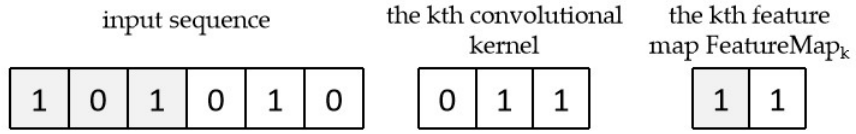
Figure 1. Convolution of a sequence with a convolution kernel.